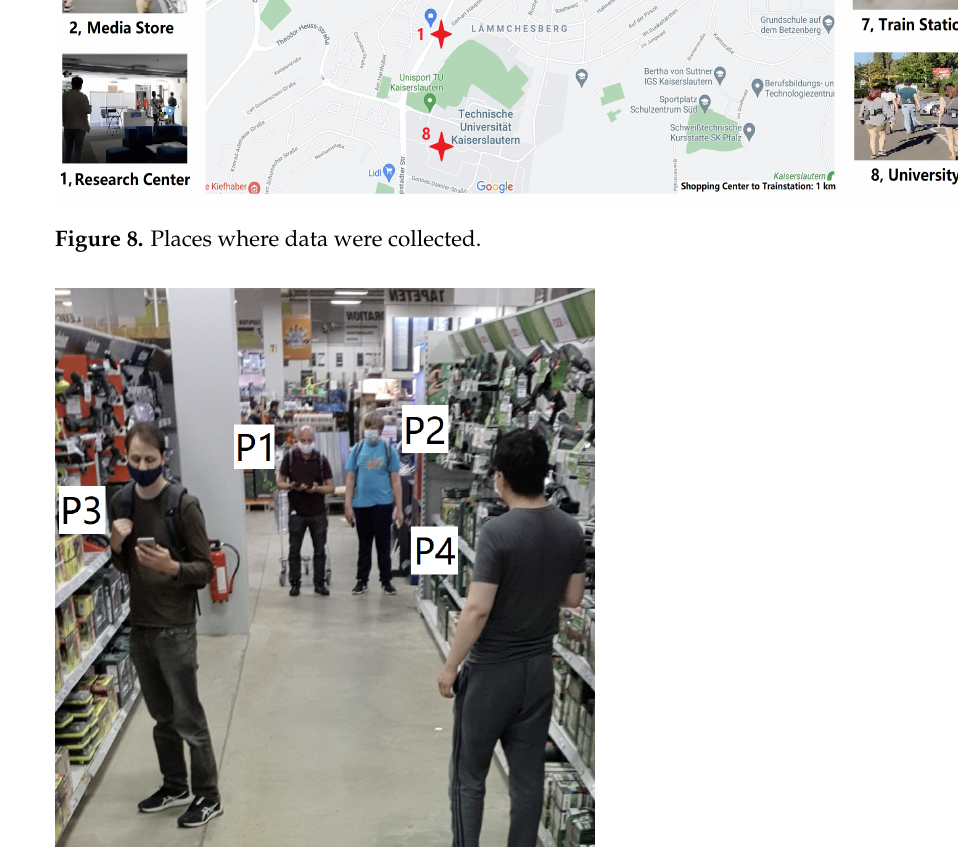
Figure 9. Collecting data in a DIY supermarket. In this case P1 and P2 are very close, while P3 and P4 are at social distancing. We call the distance between both groups (for example between P1 and P3) medium distance. Not seen in this picture is P5, who is even further away in another aisle. We call the distance to the subjects here Very